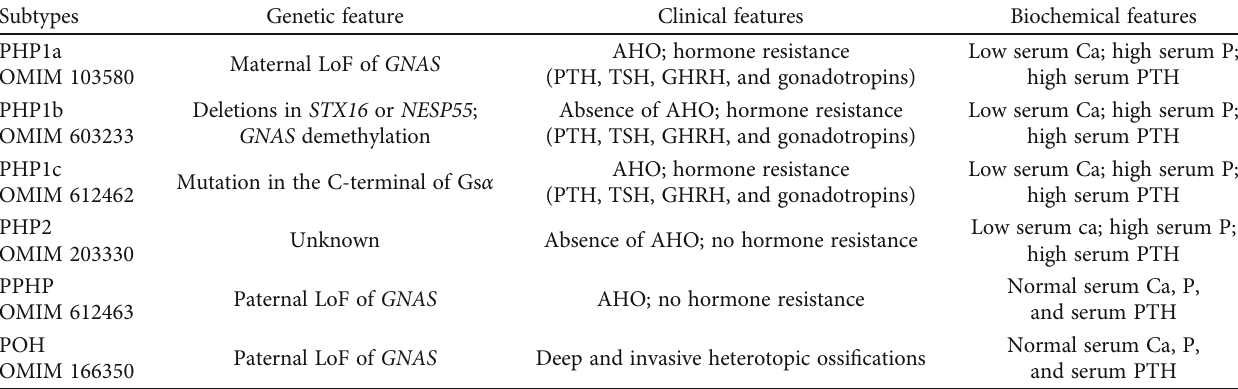
Table 1: Characteristics of PHP subtypes with genetic, clinical, and biochemical features [1, 4,